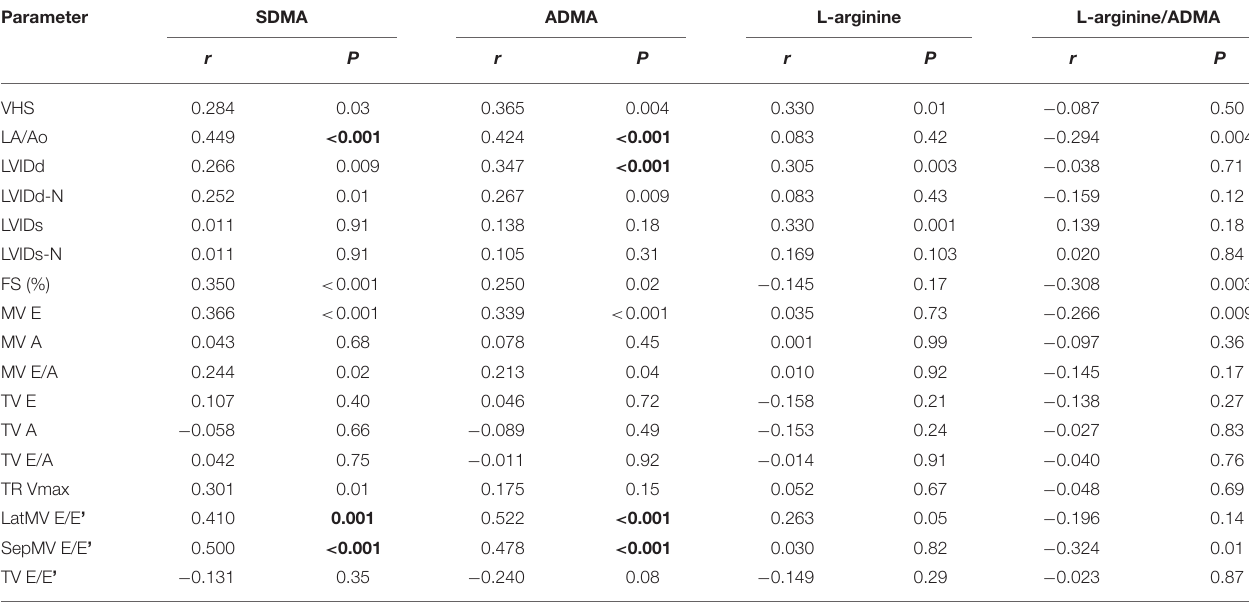
TABLE 4 | Spearman’s ranks correlations index between symmetric dimethylarginine (SDMA), asymmetric dimethylarginine (ADMA), L-arginine, L-arginine/ADMA and radiographic and echocardiographic parameters obtained from 11 control dogs and 85 dogs with myxomatous mitral valve disease at different diseases stages. Parameter SDMA